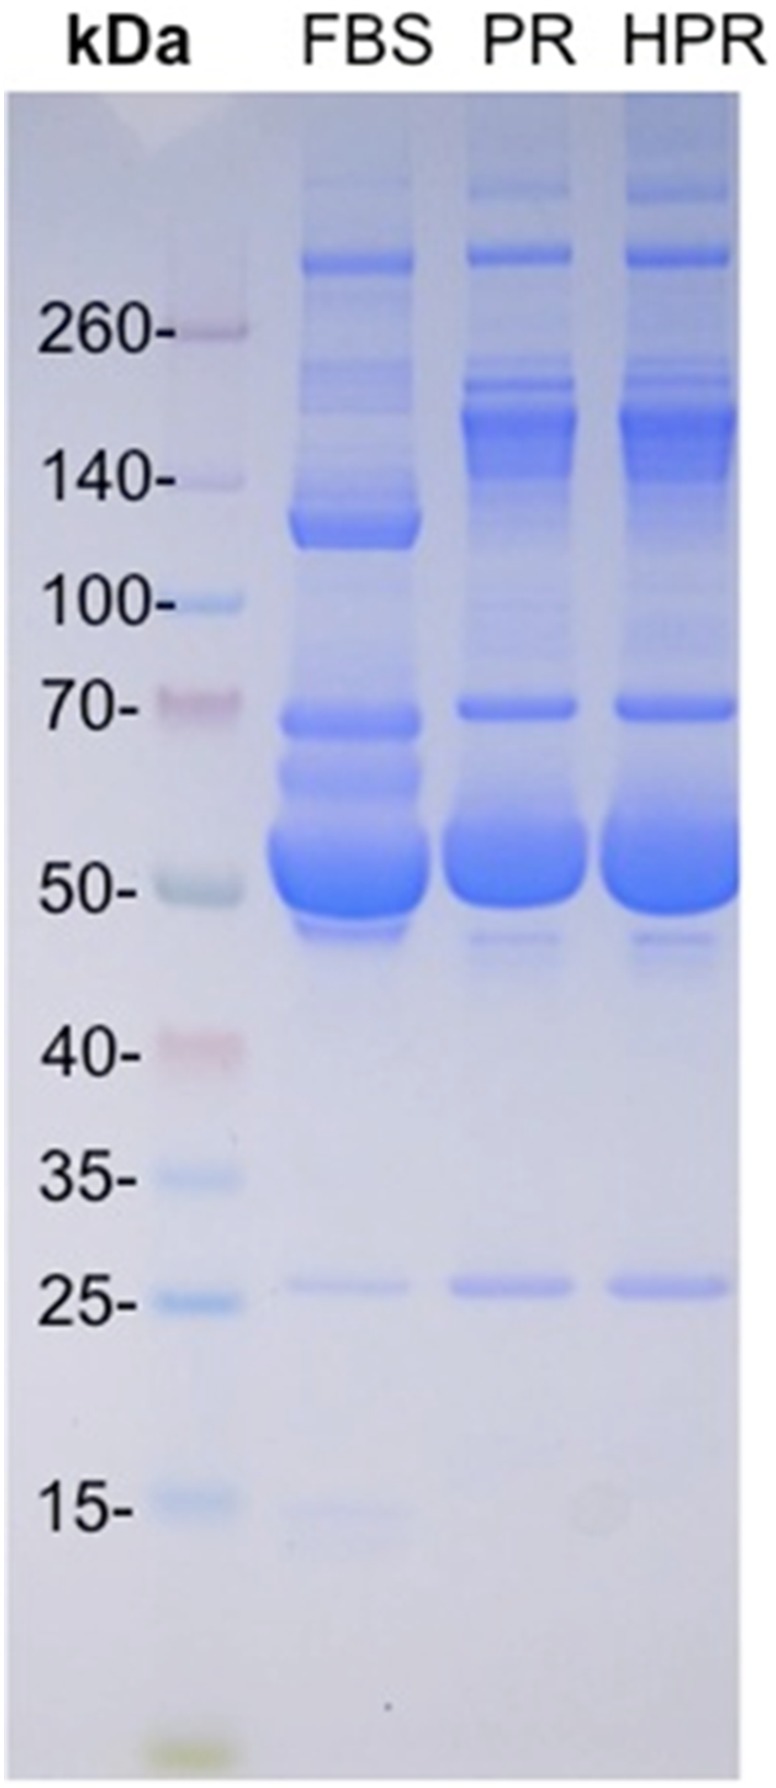
SDS-PAGE under non-reduced conditions.Molecular weight protein markers (a), fetal bovine serum (FBS, b), platelet releasate (PR, c), and heat-treated PR (HPR, d). Patterns show the absence of fibrinogen (about 260 kDa) in FBS, PR, and HPR, higher contents of immunoglobulin G (160 kDa) in the PR and HPR, and the presence of albumin (58 kDa) as the main protein component in FBS, PR, and HPR.